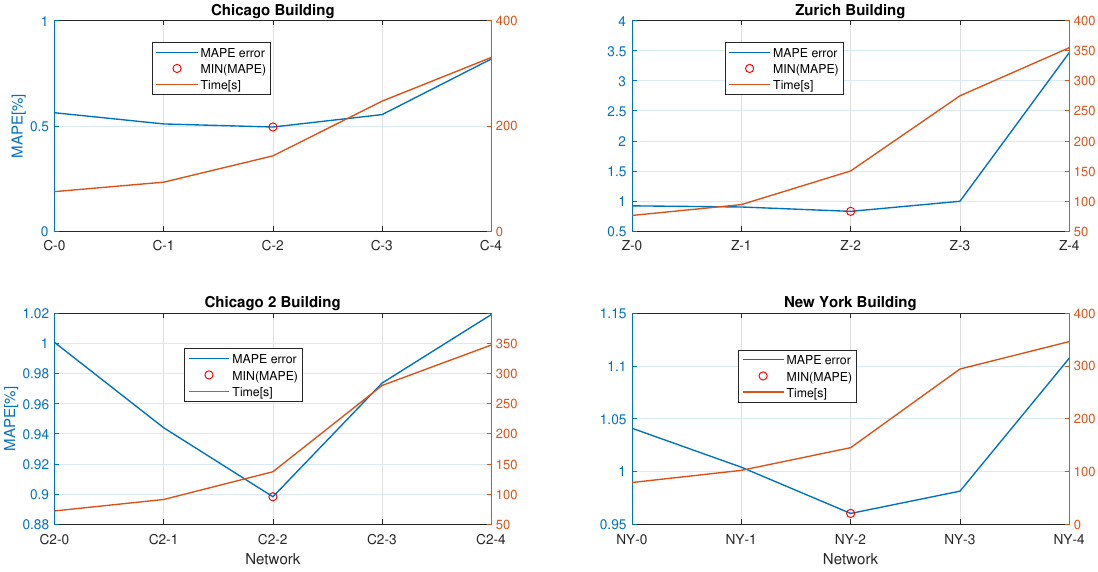
Figure 9. Computation time vs. MAPE evolution for each building.